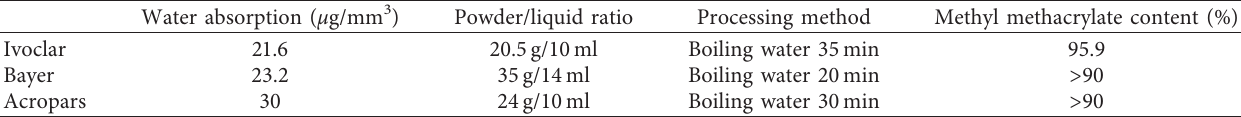
Table 1: Physical properties of three brands of heat-cured acrylic